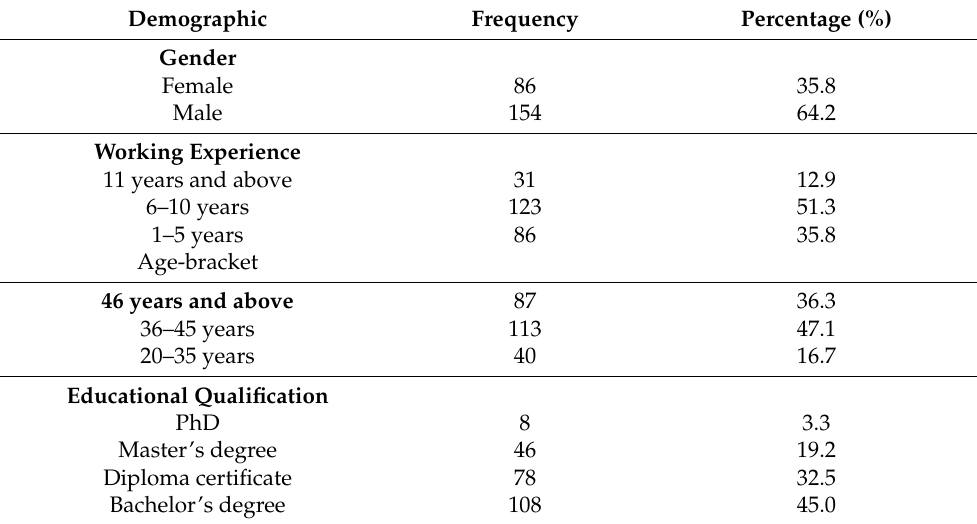
Table 1. Demographic profiles of participants.